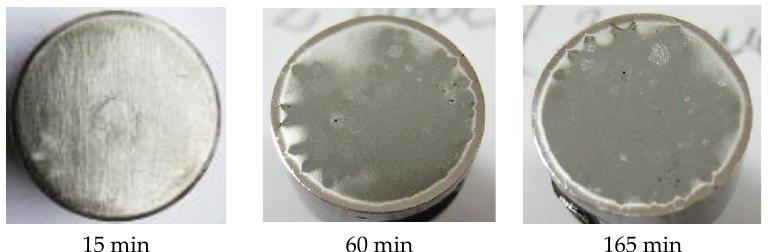
Figure 10. Macrographic image of the unmelted surface of GX40CrNiSi 25-20 sample.